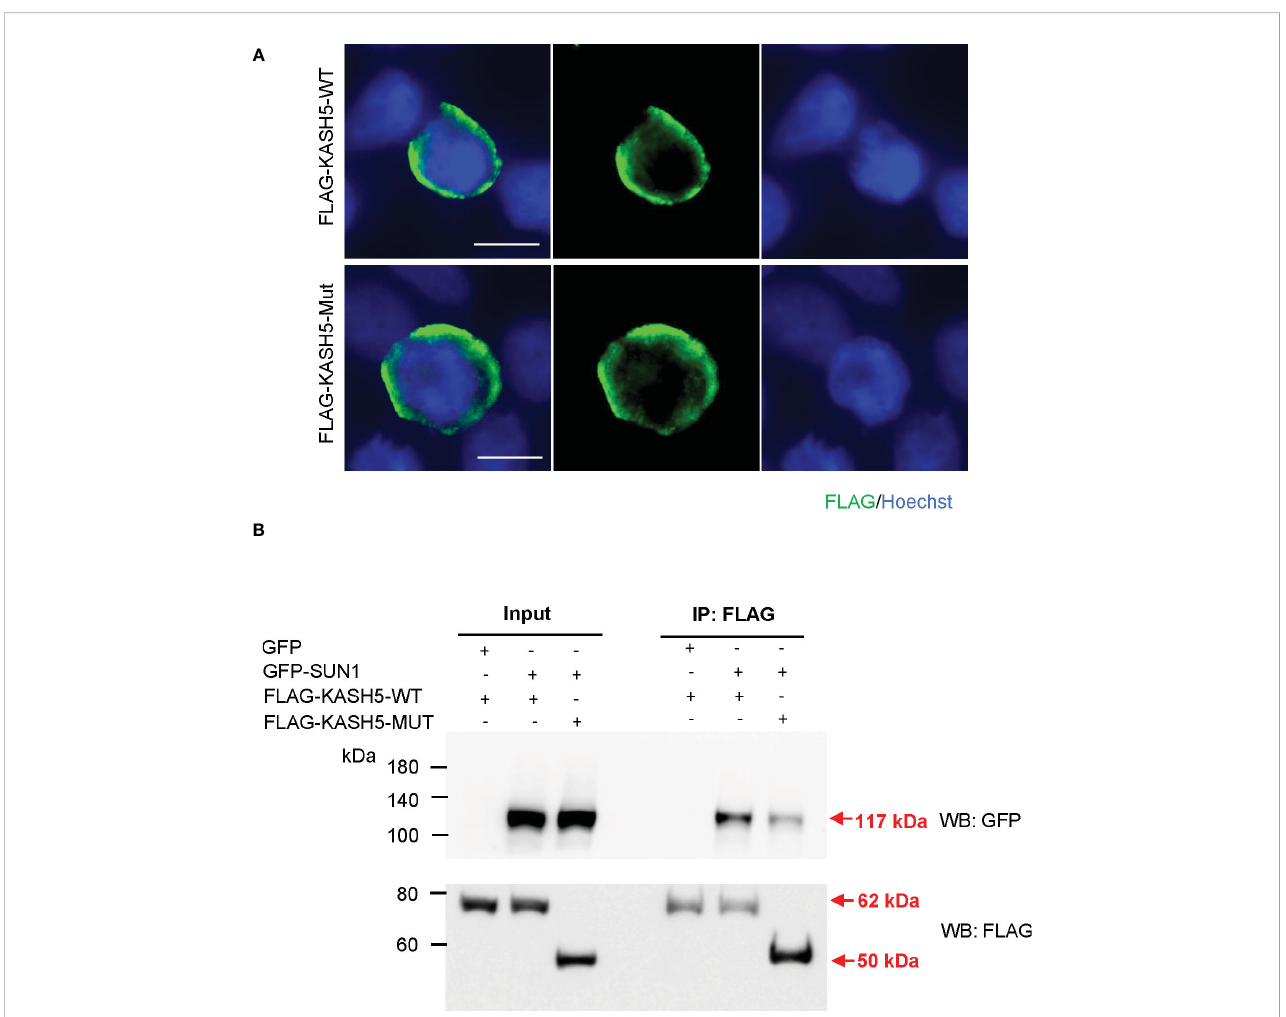
FIGURE 3 Diminished interaction between the predicted truncated KASH5 and SUN1. (A) Immuno fl uorescence staining using the anti-FLAG antibodies in HEK293T cells transfected with plasmids expressing FLAG-KASH5-WT or FLAG-KASH5-MUT proteins. Scale bars, 10 µm. (B) Co-immunoprecipitation using the anti-FLAG antibody with HEK293T cells transfected with plasmids expressing GFP-SUN1 proteins and plasmids expressing FLAG-KASH5-WT or FLAG- KASH5-MUT proteins, followed by western blotting analyses using anti-GFP or anti-FLAG antibodies. Cells transfected with GFP-empty plasmids serves as a negative co-IP control. Arrows indicate the bands corresponding to the proteins of